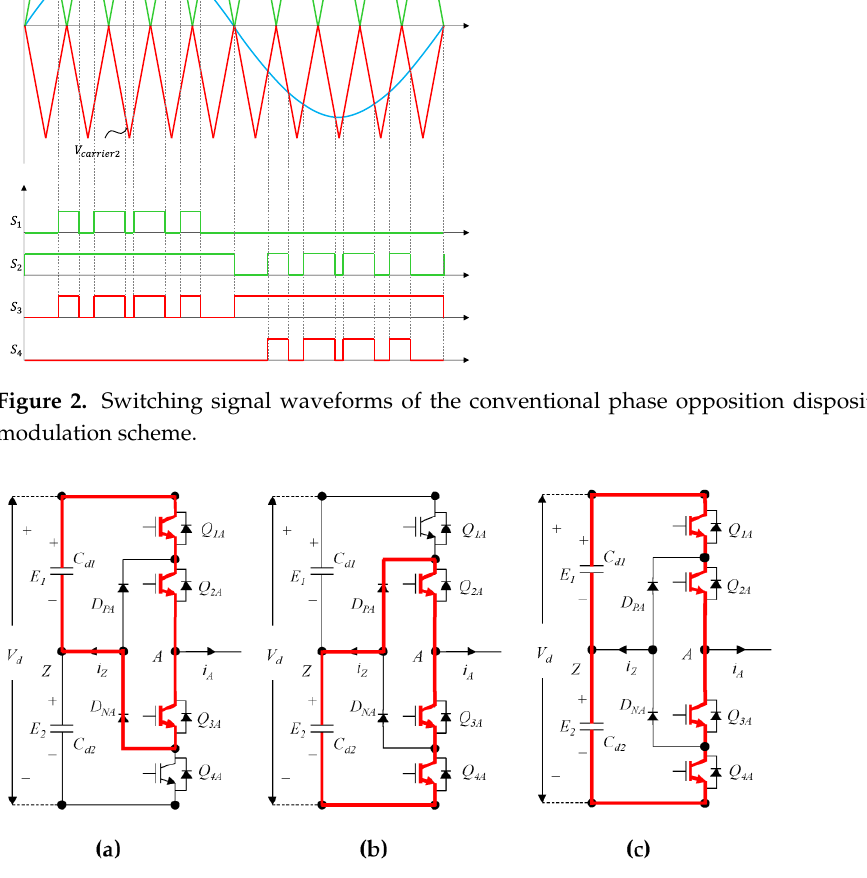
Figure 3. Current path of the short circuit for phase A : ( a ) transition of mode- P and mode- O ; ( b ) transition of mode- N and mode- O ; ( c ) transition of mode- P and mode- N .